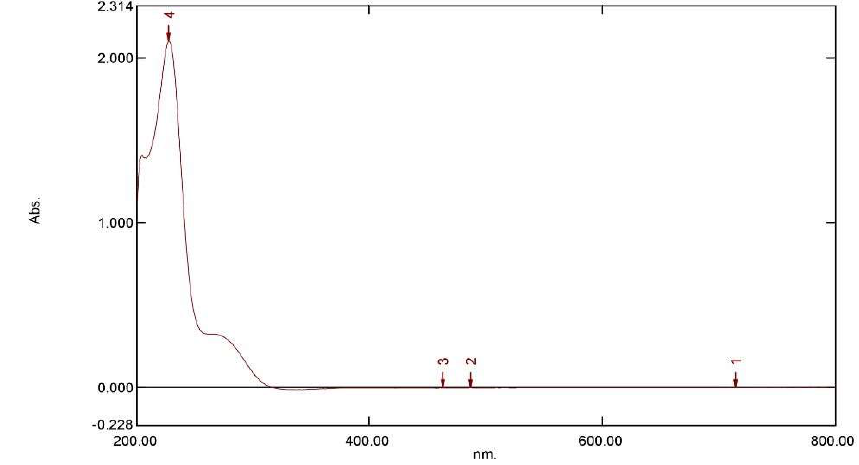
Figure 2. UV–visible absorption spectra of sinigrin in 0.02 M TBA in water (pH 7): ACN (80:20%, v / v ).